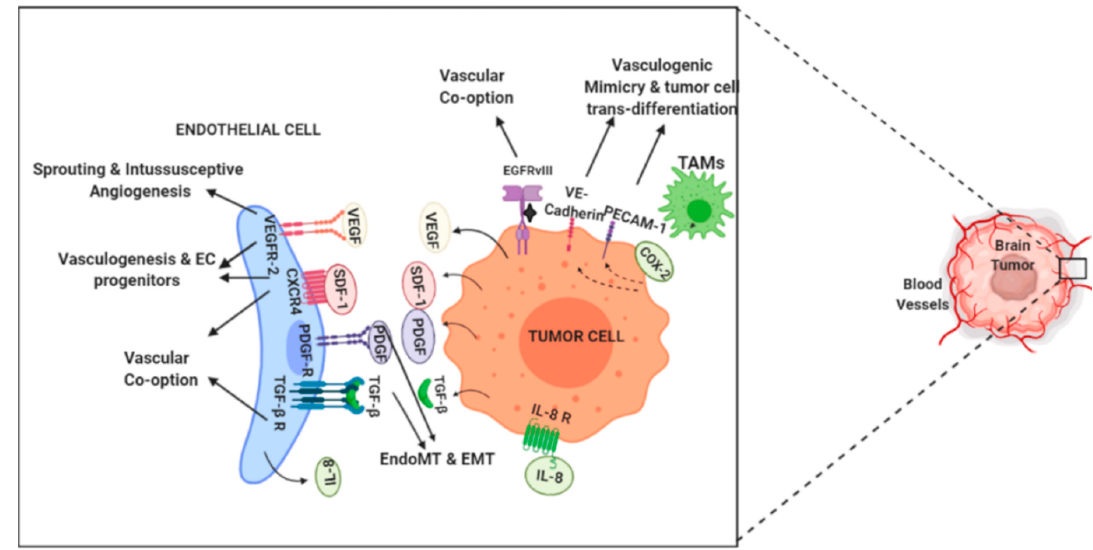
Figure 1. Mechanisms and molecular mediators involved in formation of new vessels that promote further tumorigenesis in brain and CNS tumors . Secreted factors from the tumor cells such as VEGF, SDF-1, PDFG, and TGF- β act upon respective receptors on the endothelial cells and trigger new vessel formation mechanisms such as sprouting and intussusceptive angiogenesis, vasculogenesis, vascular co-option, and recruitment of endothelial cells (EC) from the bone marrow. PDGF and TGF- β also trigger mechanisms such as EndoMT (on the endothelial cells) and EMT (on nearby epithelial